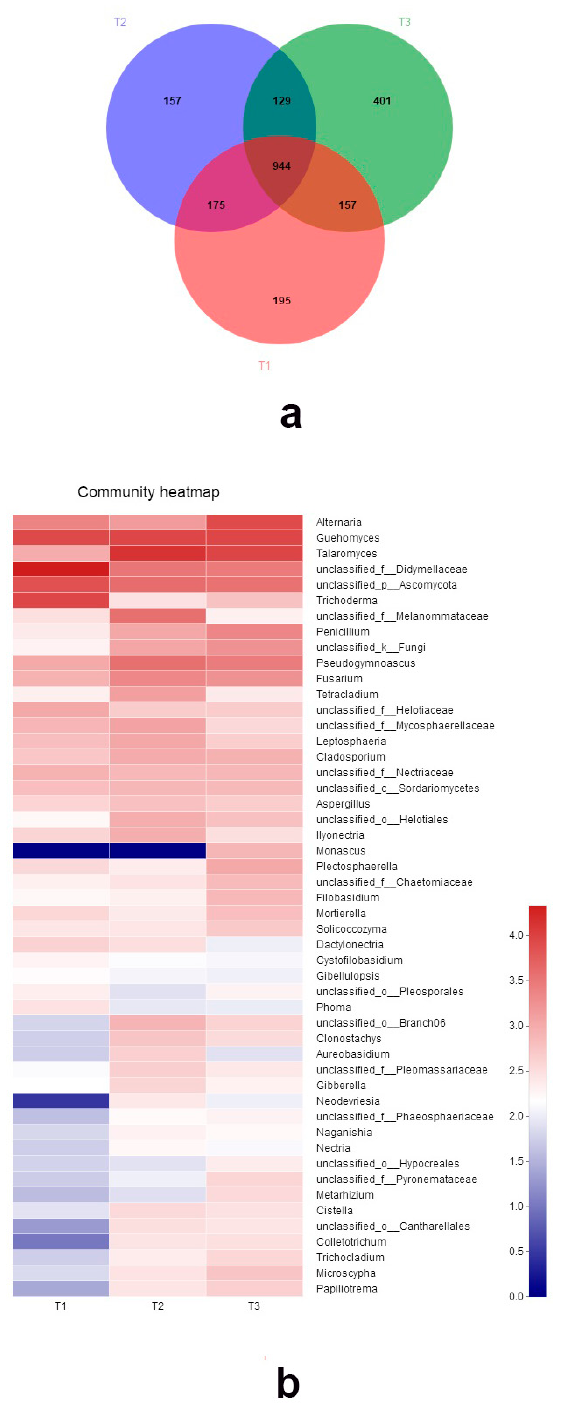
Figure 4. Fungal community among three peach cultivars: ( a ) Heatmap of the top 50 genera of three cultivars; ( b ) Venn diagram showing shared and unique fungal OTUs of three Pinggu peach cultivars.